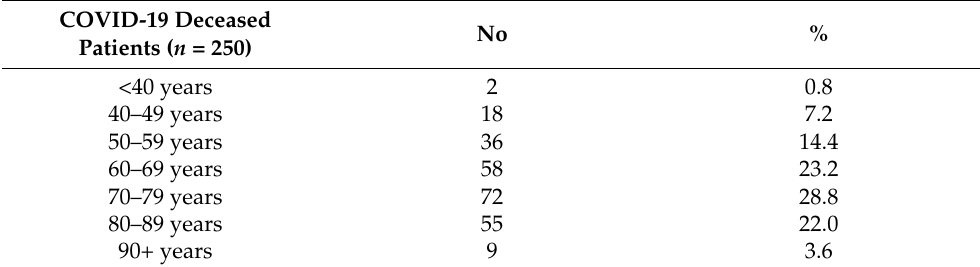
Table 2. Distribution of deaths by age